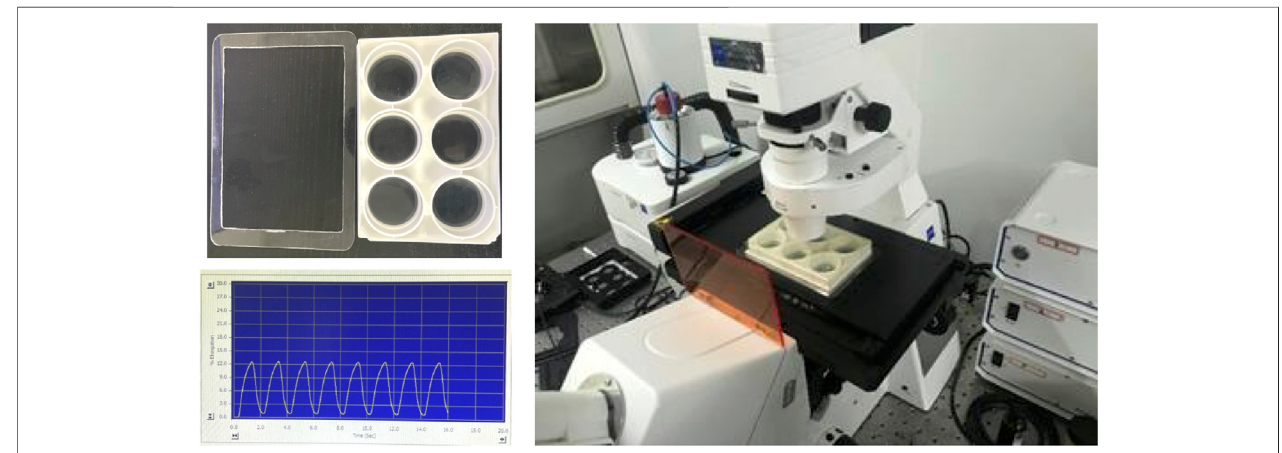
FIGURE 1 | The setup to load the BioFlex plate on the microscope stage for FRET imaging, and the sample of 0.5-Hz sinusoidal curve from cyclic stretch by using the Flexcell ® System.